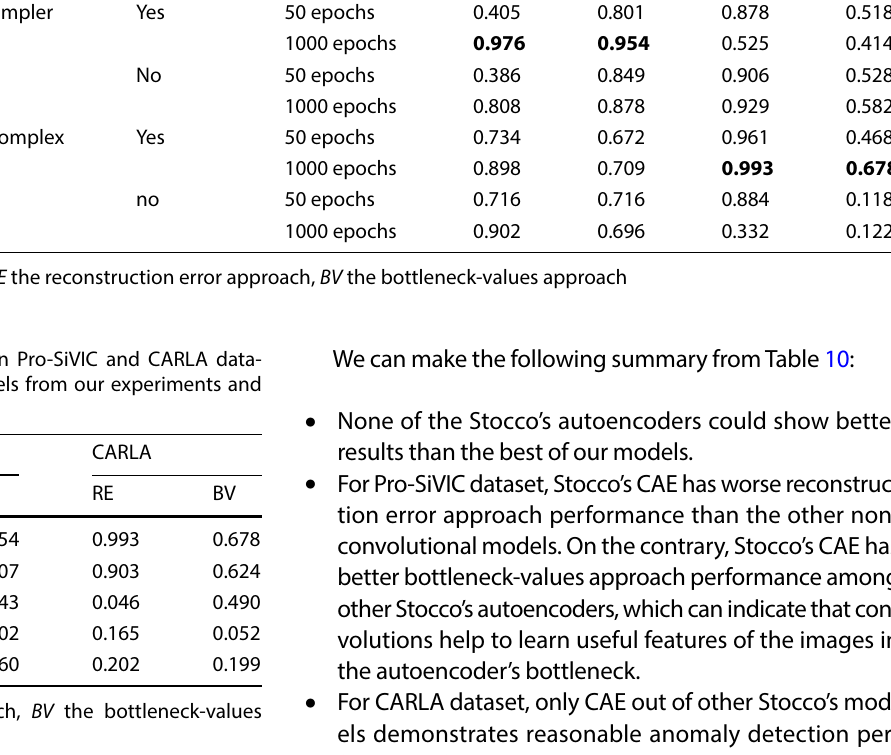
RE the reconstruction error approach, BV the bottleneck-values